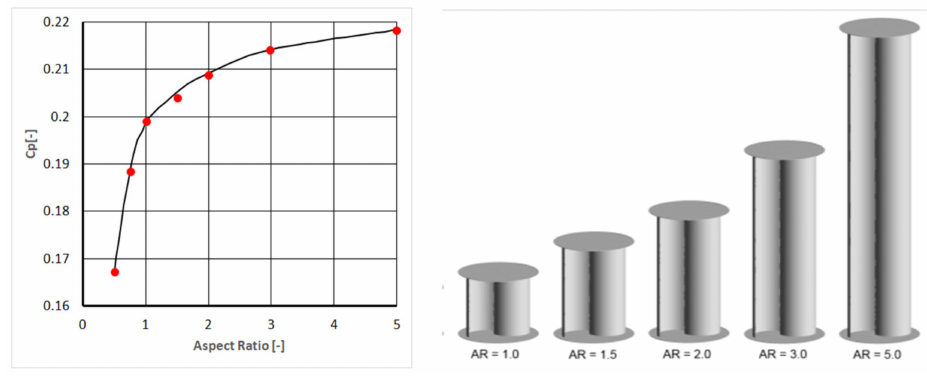
Figure 5. Two-bladed Savonius rotor aspect ratio effect